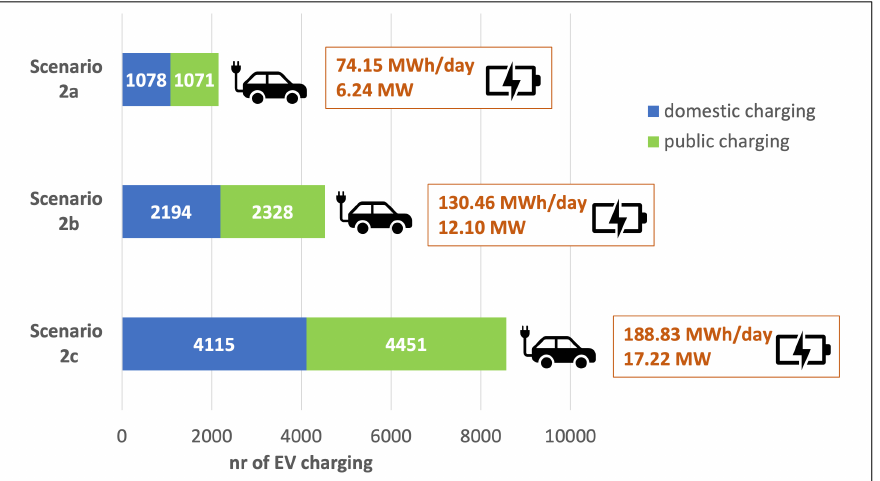
Figure 10. Number of vehicles charging, daily energy and peak demand required to the grid for the different scenarios at 2035.